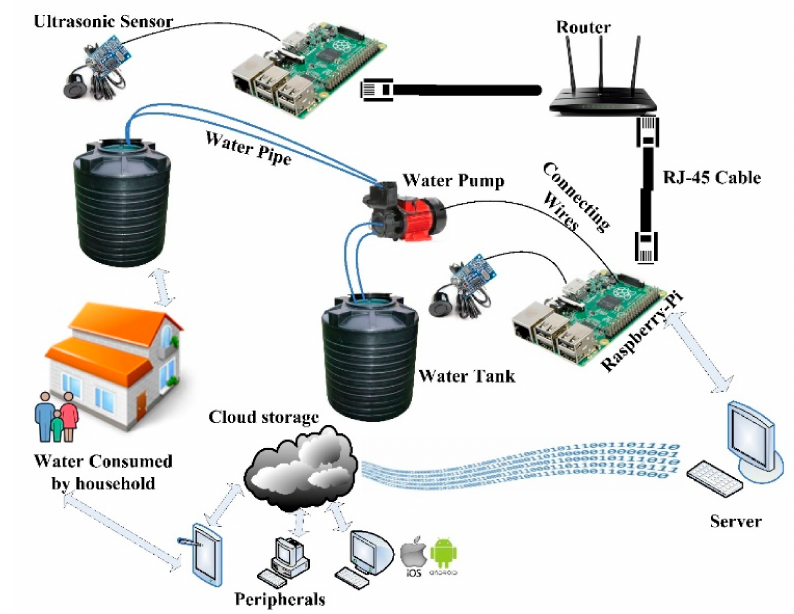
Figure 3. Experimental